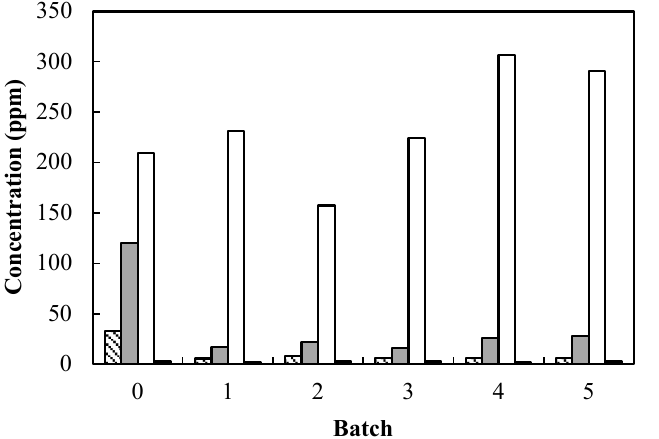
Figure 9. Grapefruit juice debittering in repeated batch operations using naringinase immobilized in OGA. Concentration of bitter compounds after 24 h of reaction. Limonin; Naringin; □ Prunin; ∎ Naringenin.